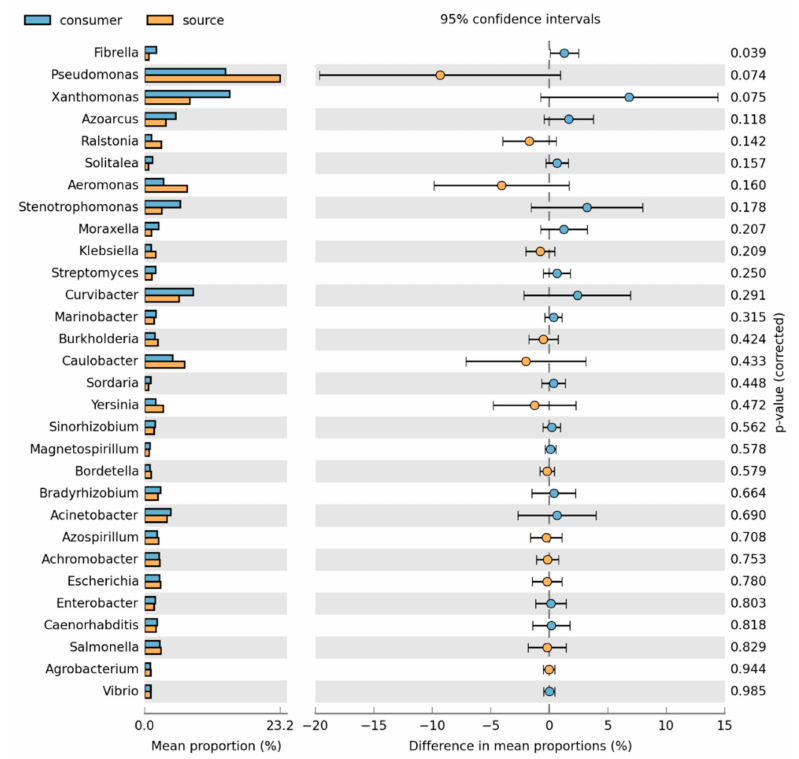
Figure 4. Differential abundance profile (genus level) between source and consumer-end biofilm samples on the basis of Fischer’s exact t -test with Storey’s FDR correction at 95% confidence